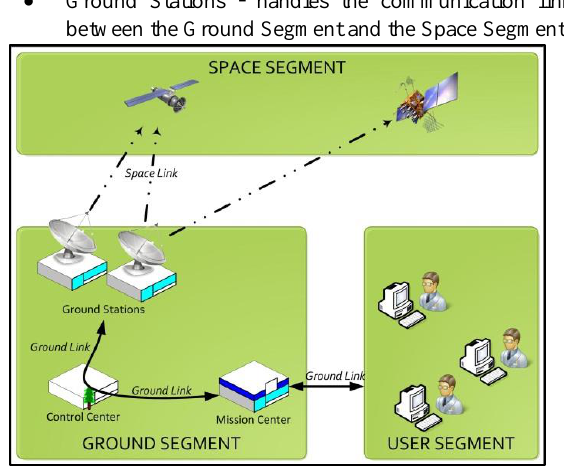
Fig. 1. Ground Segment and its relations to other space mission segments Ground Segment provides facilities and resources to control and operate the Space Segment artifacts, as satellites. Activities of the Satellite Control Center, for instance, briefly depicted in Fig. 2, are divided into flight dynamics, mission planning